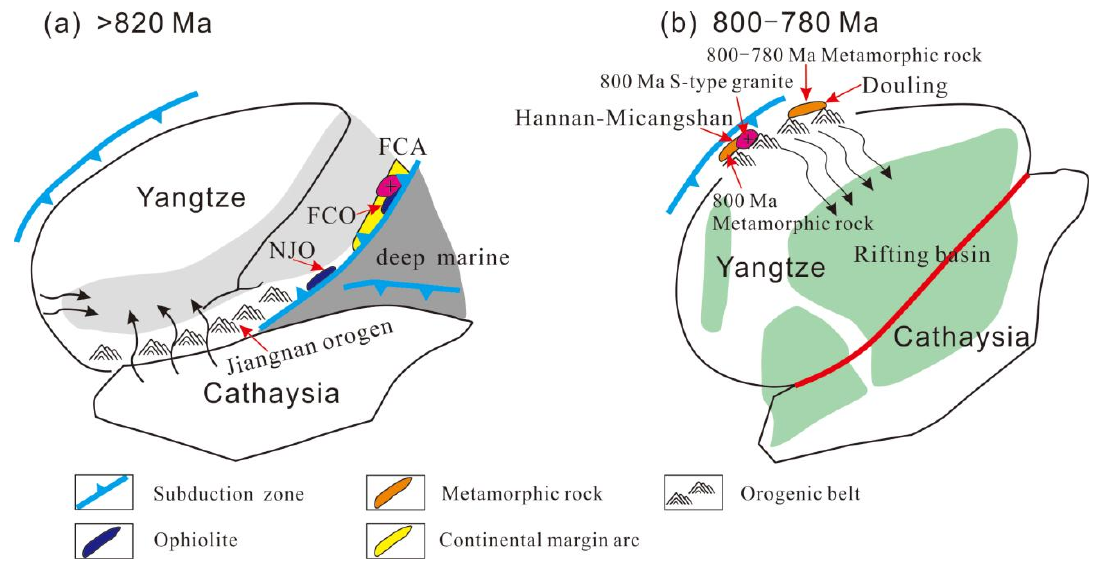
Figure 12. Scheme illustrating the orogenic events around the Yangtze Block. ( a ) A scissor-like clo- sure process occurred in the southeastern margin of the Yangtze Block; ( b ) 800–780 Ma collisional orogeny in the northern and northwestern margins of the Yangtze Block (NJO—Northern Jiangxi ophiolite; FCO—840–820 Ma SSZ-type Fuchuan ophiolite; FCA—Fuchuan continental margin arc; Modified after [17,125]).